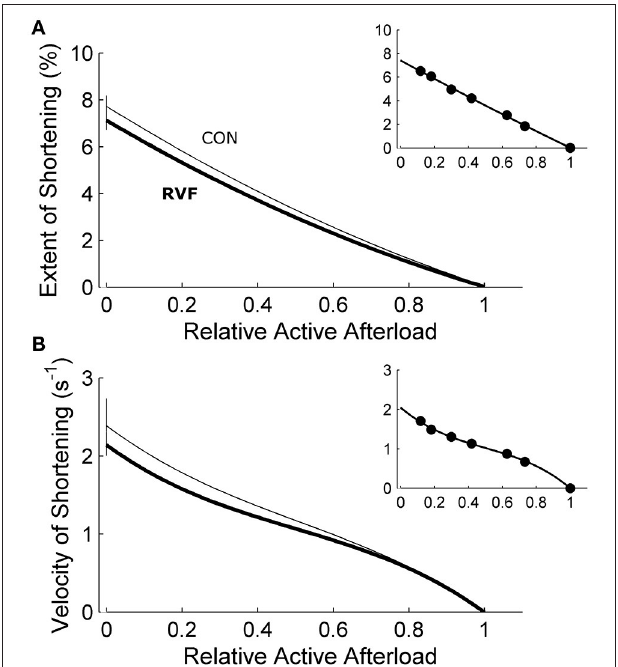
FIGURE 7 | Shortening of in vitro left-ventricular trabeculae during work-loop contractions. Extent of shortening (A) (calculated as the widths of the loops in Figure 6C ) and maximal velocity during shortening (B) (calculated as the maximal slope of length change during the isotonic shortening phase of the loop; see the inset of Figure 6C ) were not different between the control trabeculae (thin lines) and the RVF trabeculae (thick lines). The insets display data obtained from a representative trabecula.